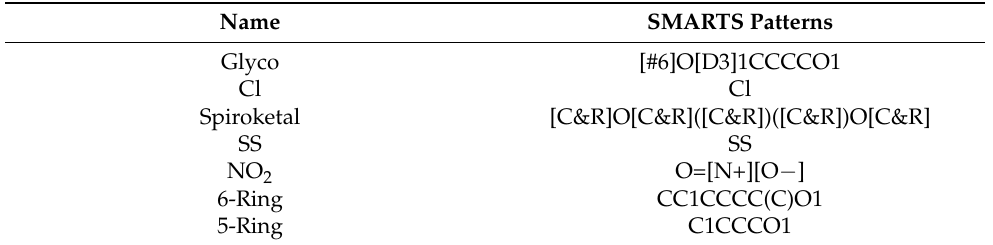
Table 13. SMARTS patterns used to match PSMs in known BGC products described in the